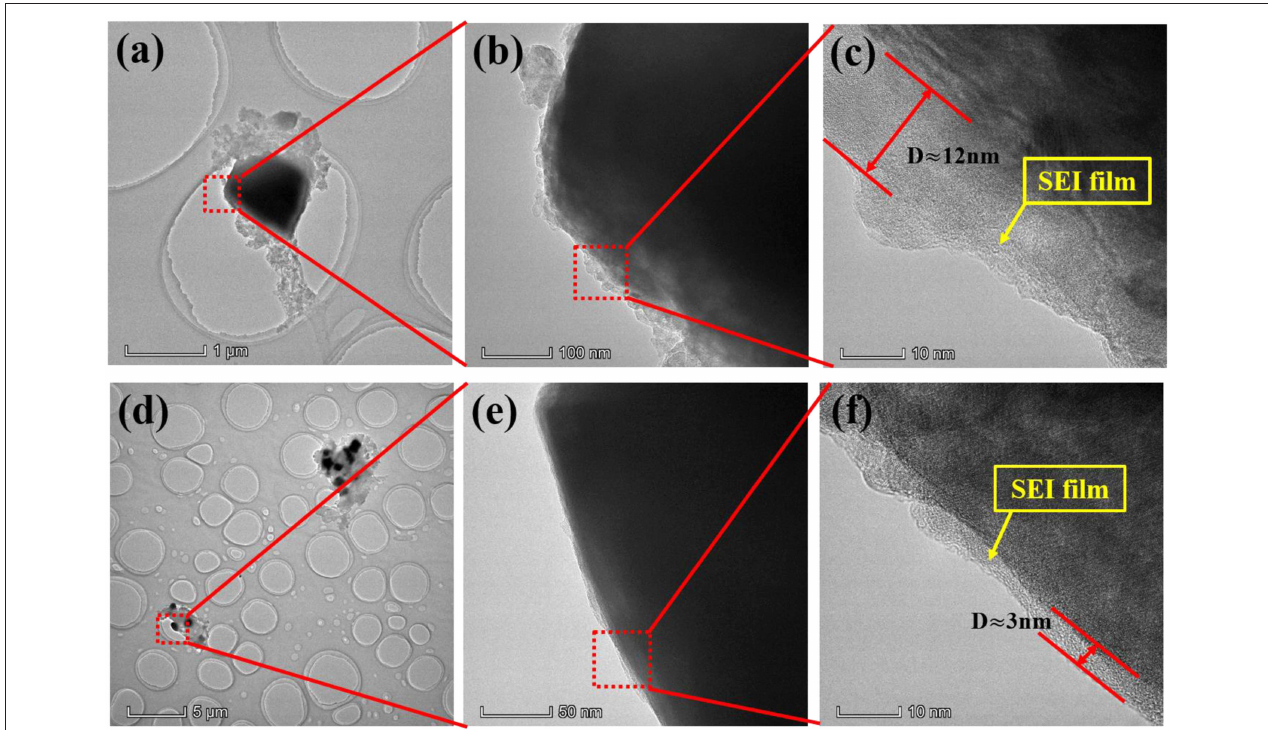
FIGURE 5 | TEM images of LNMO electrodes after 40 cycles: (a–c) no additive and (d–f) with 0.5 wt.% PTSI.